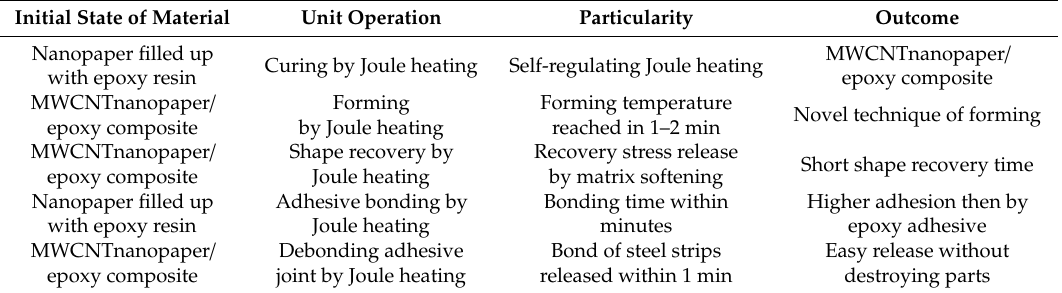
Table 1. Overview of introduced applications of the MWCNT nanopaper / epoxy